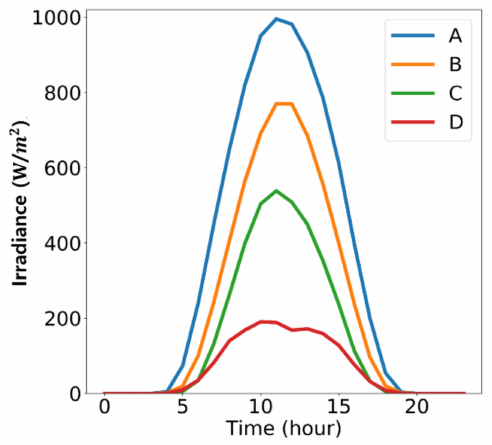
Figure 3. Average solar irradiance by weather groups